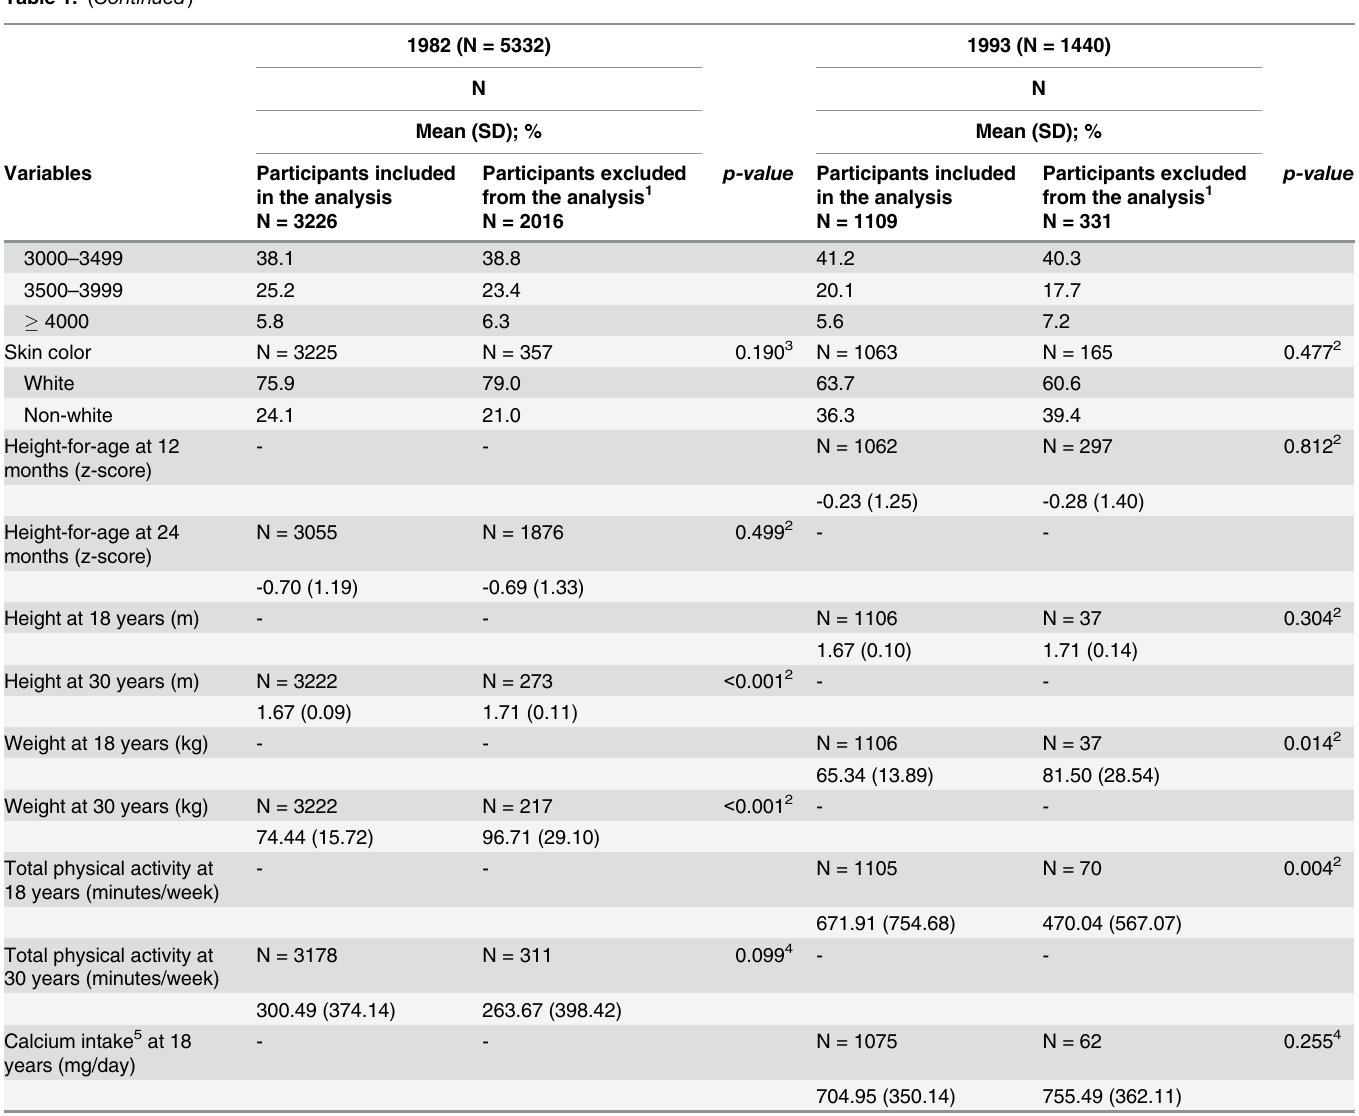
Table 2 presents the descriptive analysis of outcomes according to breastfeeding variables, stratified by sex, for both studies. Among men, the variables full breastfeeding in months and pattern of breastfeeding at three months, were associated with both outcomes at 30 years of age. When bone mass was assessed at 18 years, only total breastfeeding (in months)